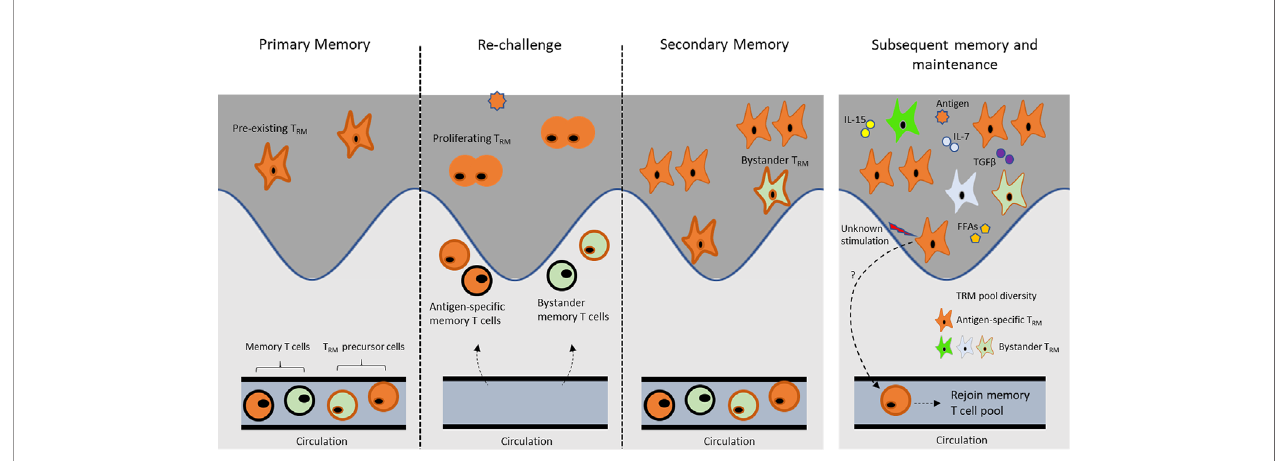
FIGURE 4 | Maintenance of skin T